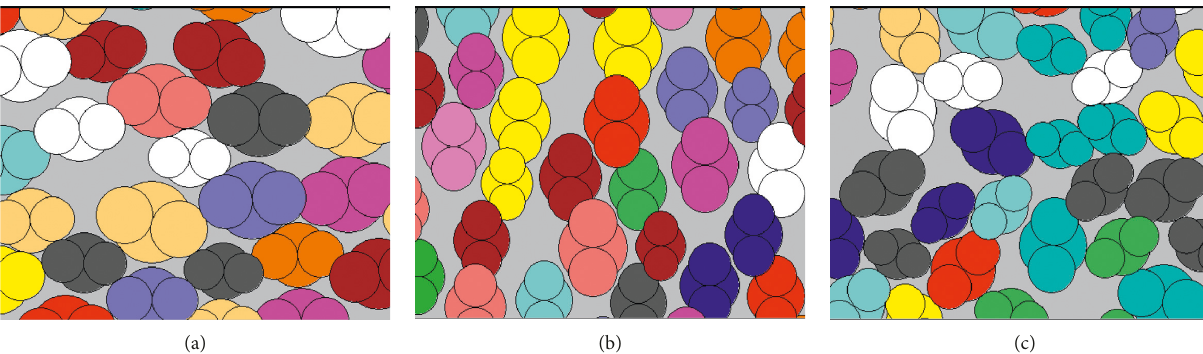
Figure 26: Three types of particles with different shapes. (a) H-type particles. (b) V-type particles. (c) R-type